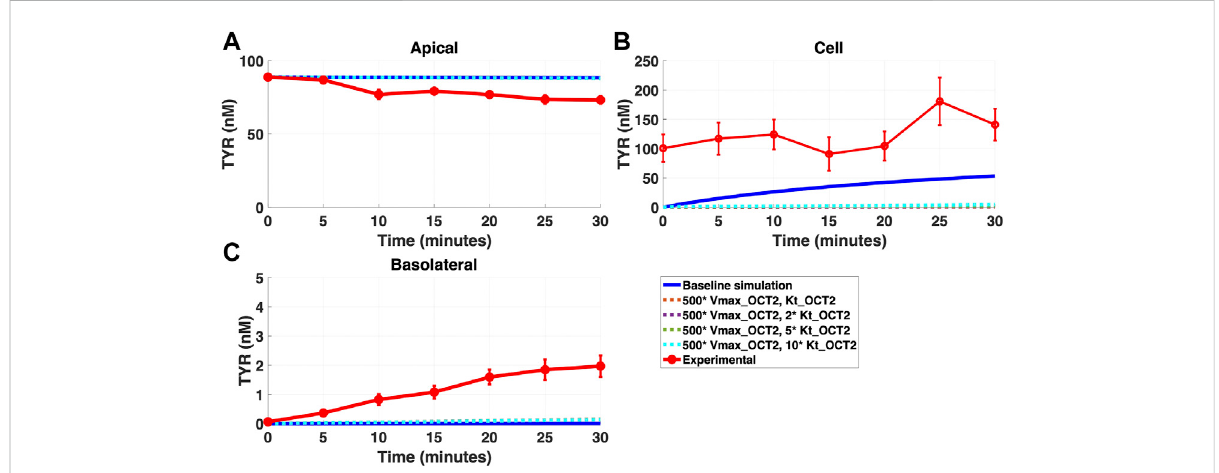
FIGURE 7 Introduction of a non-OCT2 facilitated diffusion transporter to basolateral membranes worsens model matching to experimental data following apical TYR loading. The transport of 88.9 nM of TYR across Caco-2 cells was modeled for apical loading by solving Eqs 4 – 8, using the values mentioned in Supplementary Table S2, using MATLAB vR 2021a. Comparisons were made between the models (baseline = blue curve; modi fi ed = dotted curves) and experimental observations; red curve (Sarkar and Berry, 2020) for the apical Panel 7 (A) , cellular Panel 7 (B) and basolateral compartments Panel 7 (C) . Addition of the additional transporter to the basolateral membrane decreased the ability to model experimentaldata.Kineticparametersusedforthismodellingwere:V max_OCT2 =0.1 nM/s,K t_OCT2_apicaltocell =101.5nM,V max_baso_active =43.0 nM/s, K t_baso_active = 33.1 nM, V max_baso_new_FD = 50 nM/s and K t_baso_new_FD_basotocell = 101.5 – 1,015